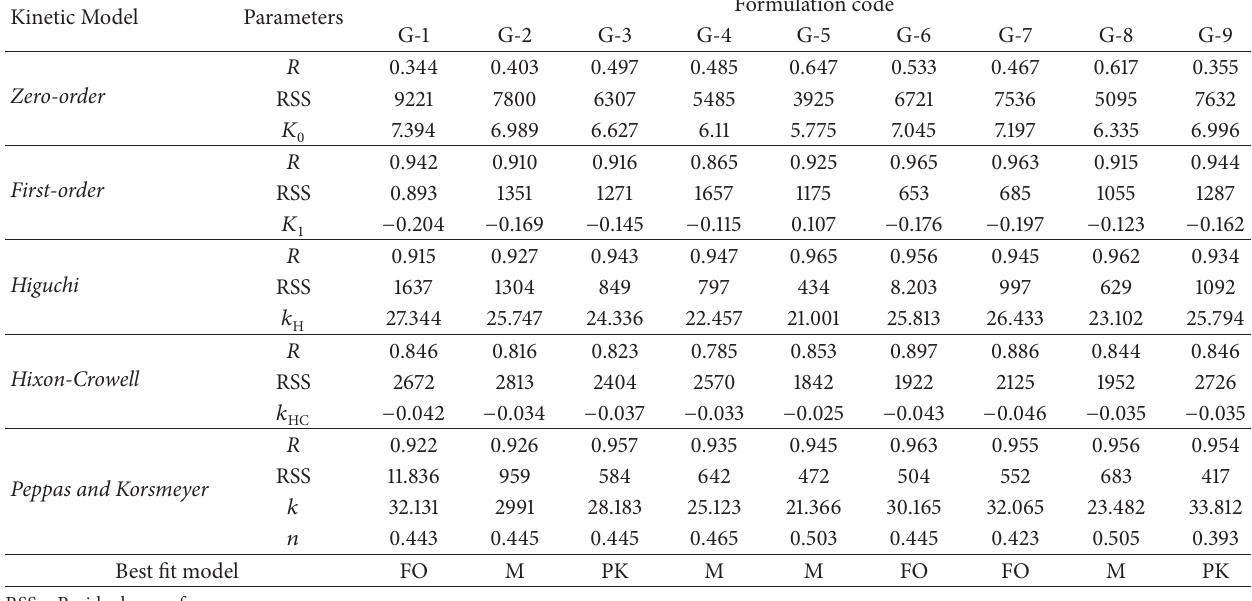
Table 7: Drug release kinetics for different